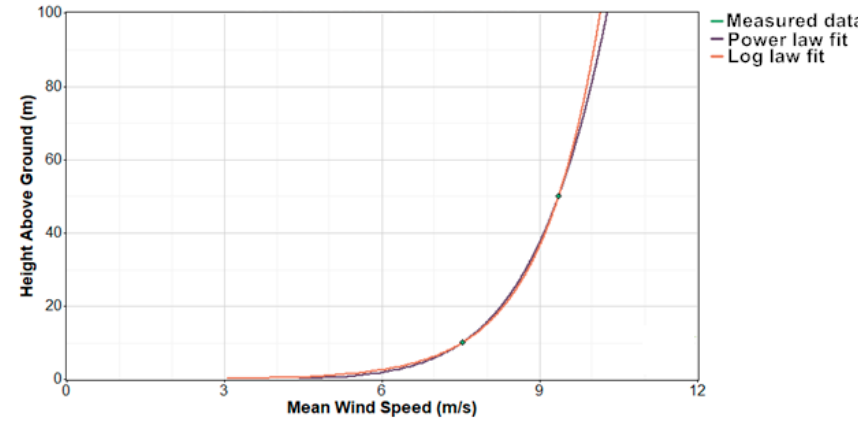
Figure 10. Vertical wind shear profile at the mast site.